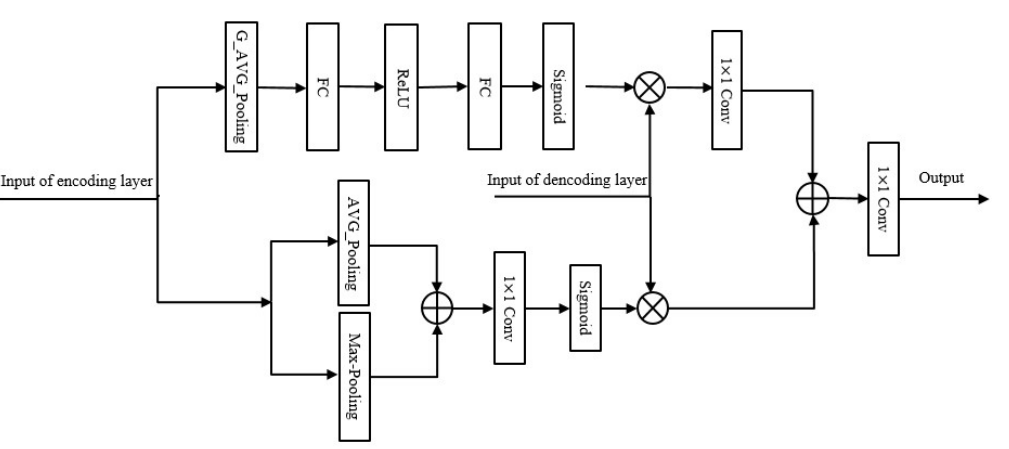
Figure 3. Structure of the AWSE